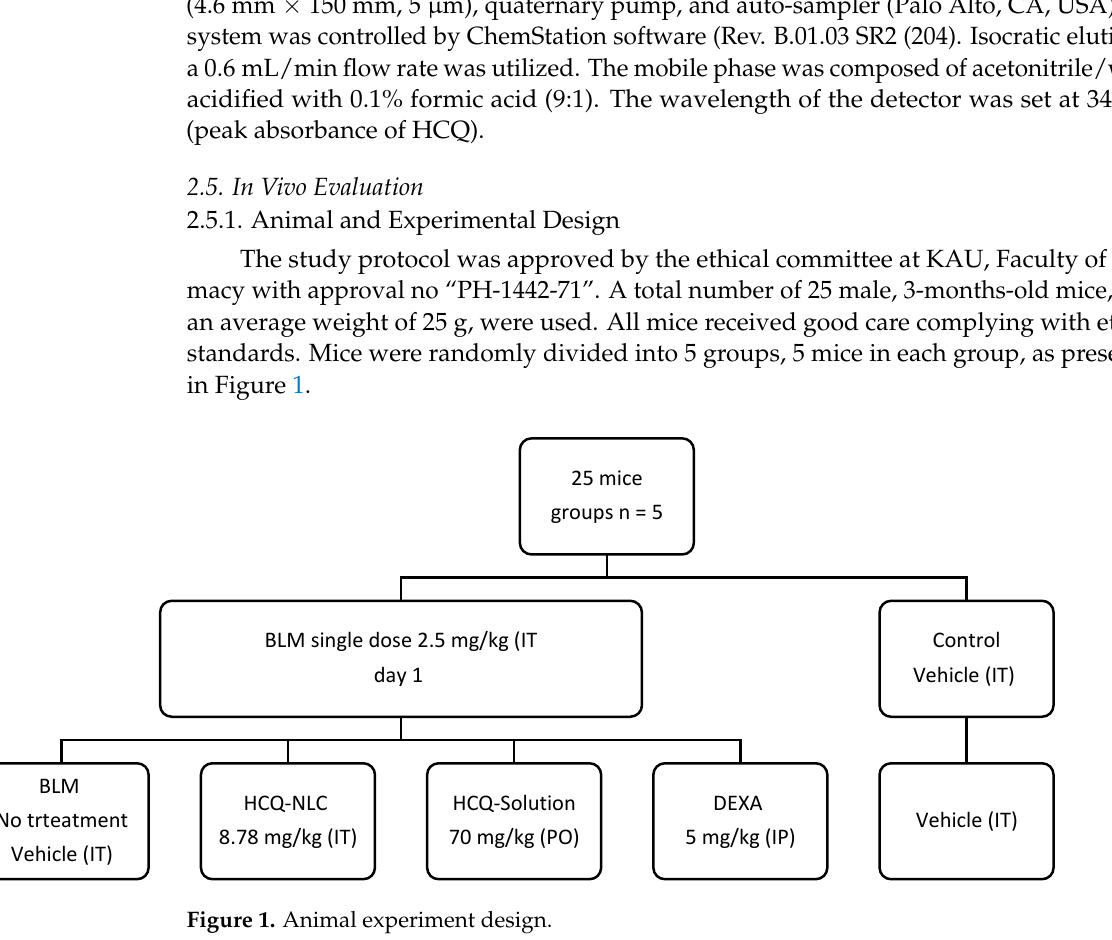
Figure 1. Animal experiment design.